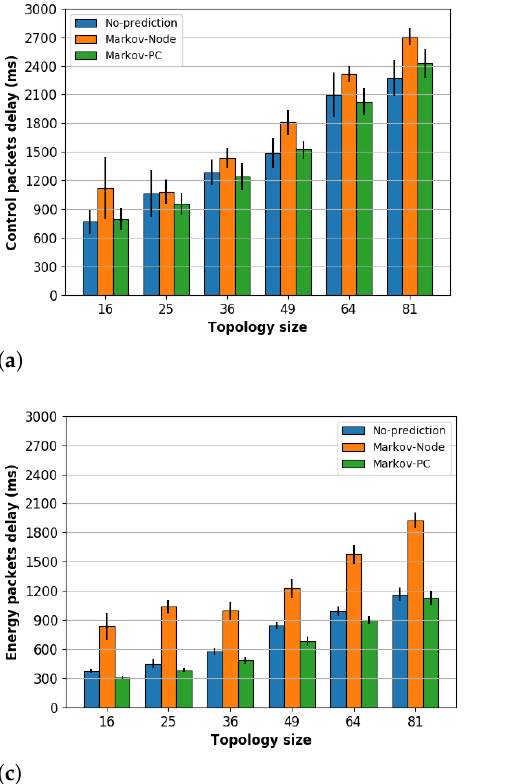
Figure 8. Packets delay of Markov chain and No-Prediction schemes: ( a ) shows the average delay of control packets, ( b ) shows the average delay of the data packets, and ( c ) shows the average delay of energy